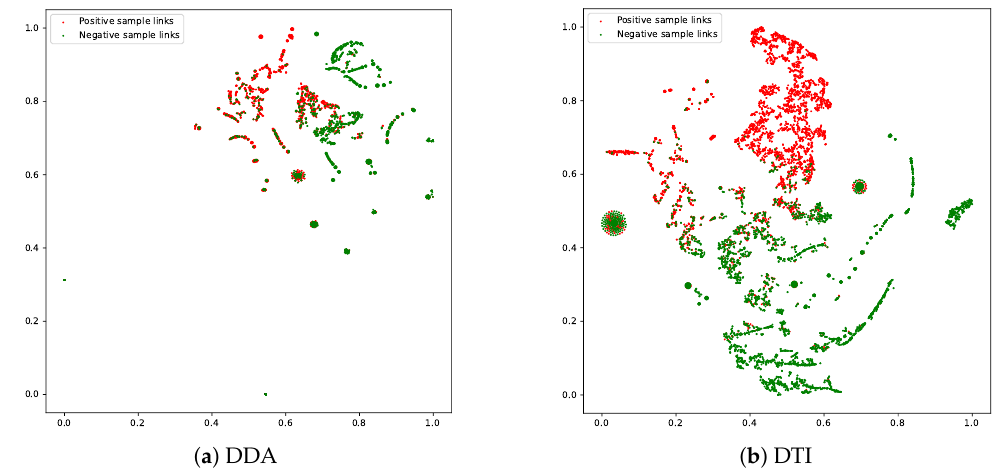
Figure 5. Visualization of learned representation for links in DDA and DTI networks. The red dots indicate the positive sample links and the green dots indicate the negative sample